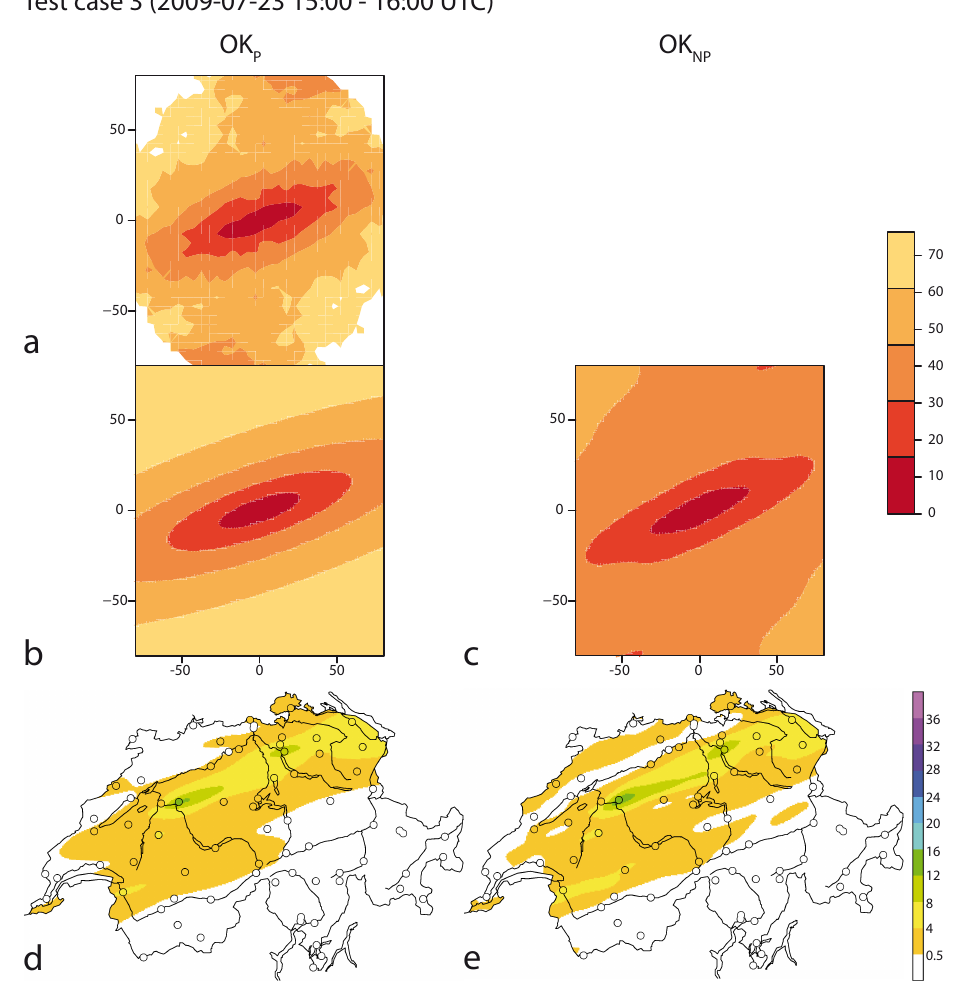
Fig. 10. As Fig. 6 but for test case 3.